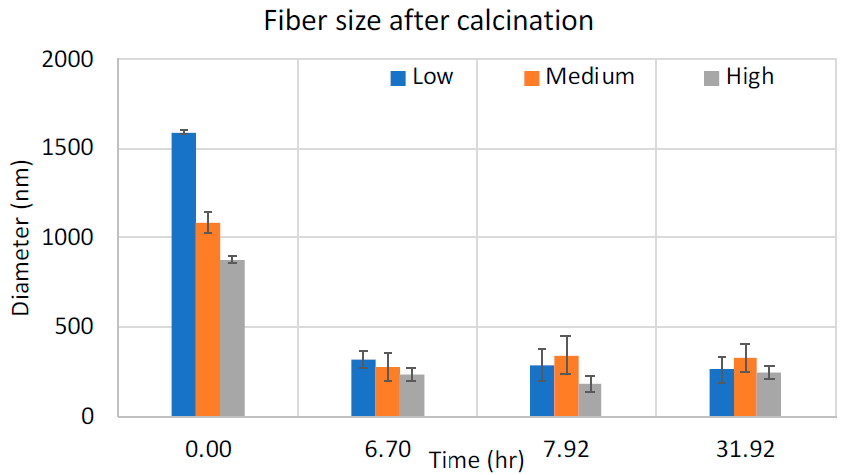
Figure 4. Measurement of fiber diameter for as-spun fiber and after calcination.